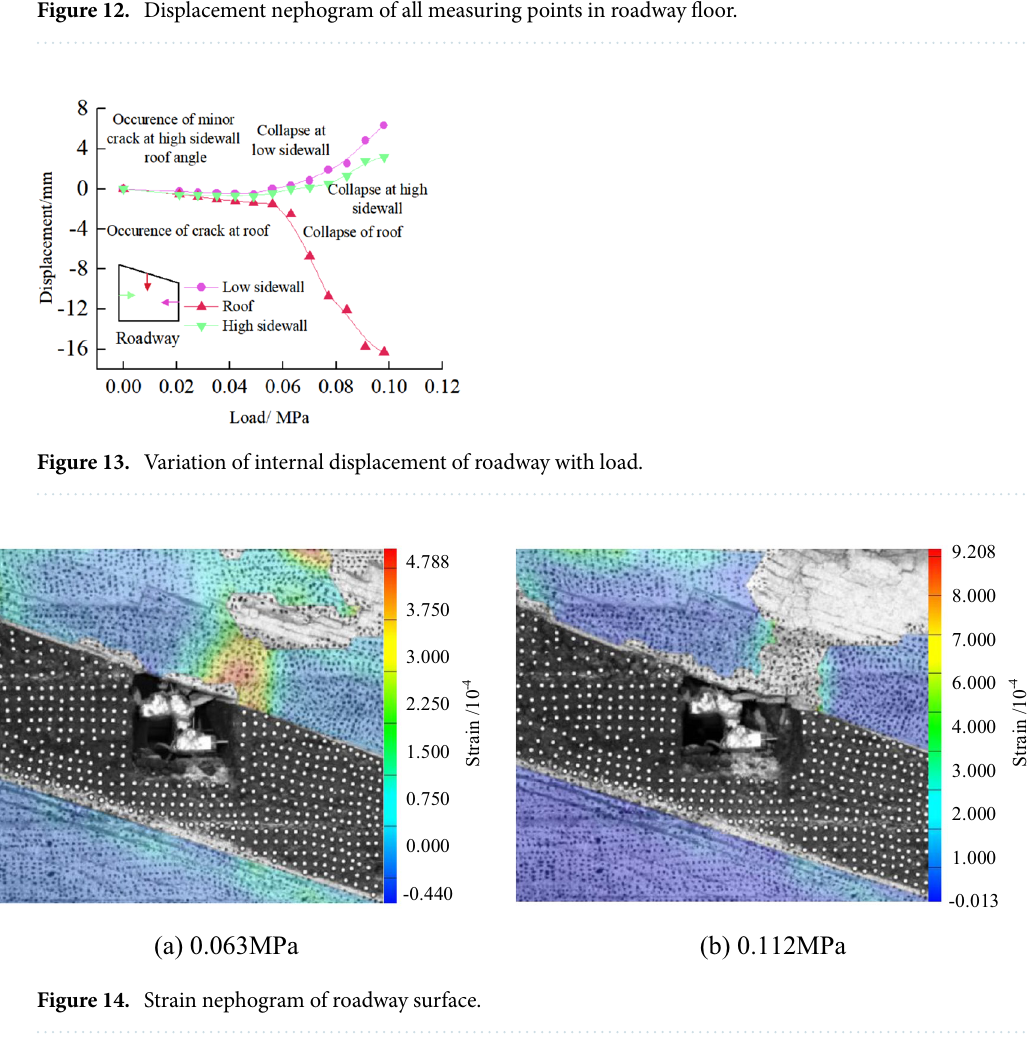
Figure 12. Displacement nephogram of all measuring points in roadway floor.